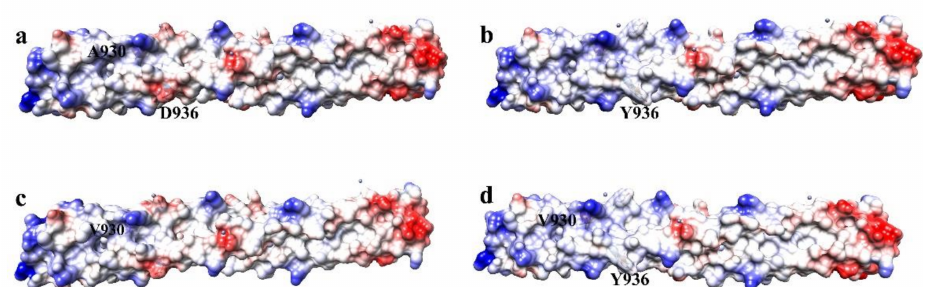
Figure 2. Electrostatic surface of HR1 domains of SARS-CoV-2: ( a ) WT, ( b ) D936Y, ( c ) A930V, and ( d ) A930V-D936Y variants. The red color indicates regions of negative charge, the blue indicates regions of positive charge. The white color indicates regions of neutral charge.